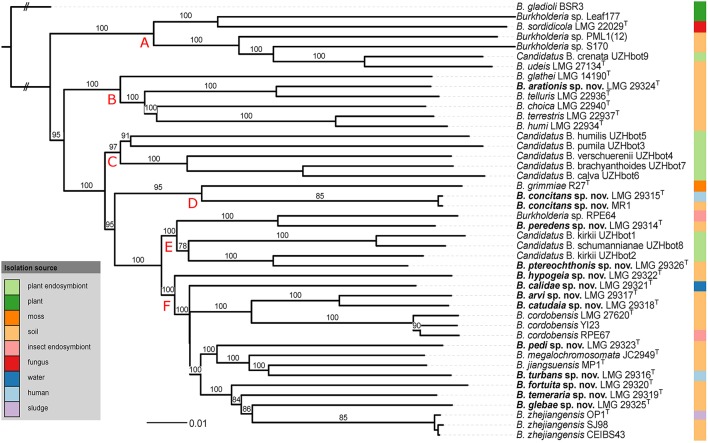
Whole-genome sequence based phylogenomic tree of all BGC genomes inferred by GBDP. The outer column shows the isolation source of the strains. Pseudo-bootstrap support values above 60% are shown. The tree reveals a high average support of 94.8%. Long terminal branches are due to the distinct scaling used by GBDP's formula d5. B. gladioli BSR3 was used as outgroup. Red capital letters define subtrees that also occur in the tree depicted in Figure 3.